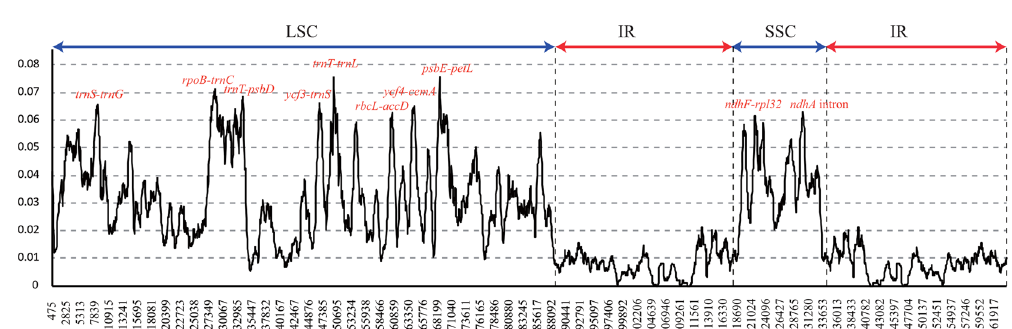
Figure 4. Sliding window analysis of the four Fagopyrum chloroplast genome sequences. The Y-axis represents nucleotide diversity of each window, while the X-axis represents position of the midpoint.